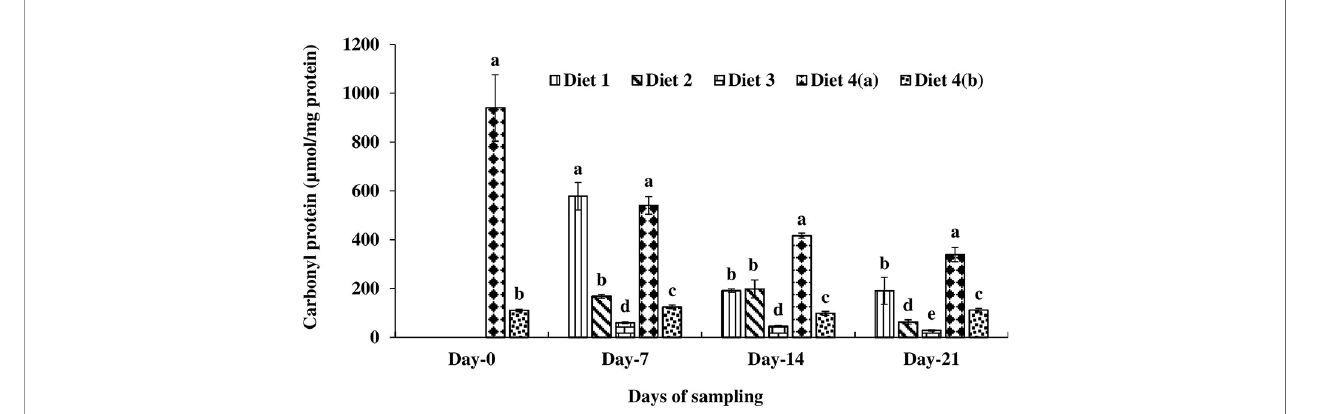
FIGURE 5 | Carbonyl protein level found in four different diets fed UV-B exposed and unexposed Catla catla . Bars with different superscripts (a-e) are signi fi cantly different (n = 3).